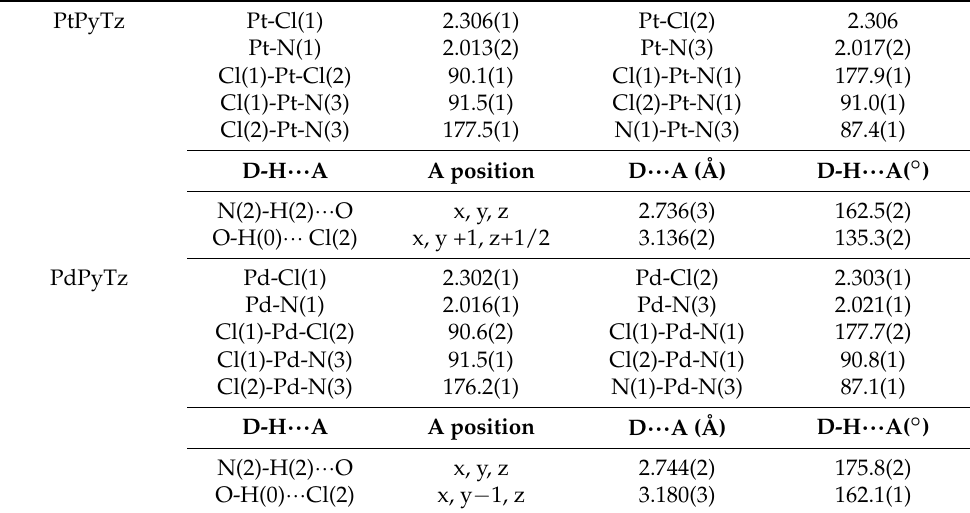
Table 2. Selected bond lengths (Å), angles ( ◦ ) and hydrogen-bond parameters for PtPyTz and PdPyTz.